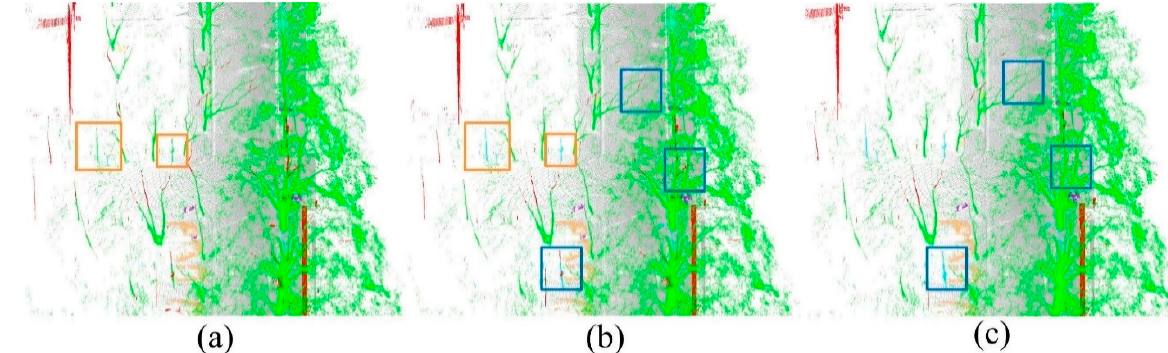
Figure 15. Classification results of different steps of the proposed method in the Wuhan University dataset. ( a ) Classification results of RF. ( b ) Classification results of higher-order CRF. ( c ) Classification results of higher-order CRF considering small-label clusters.